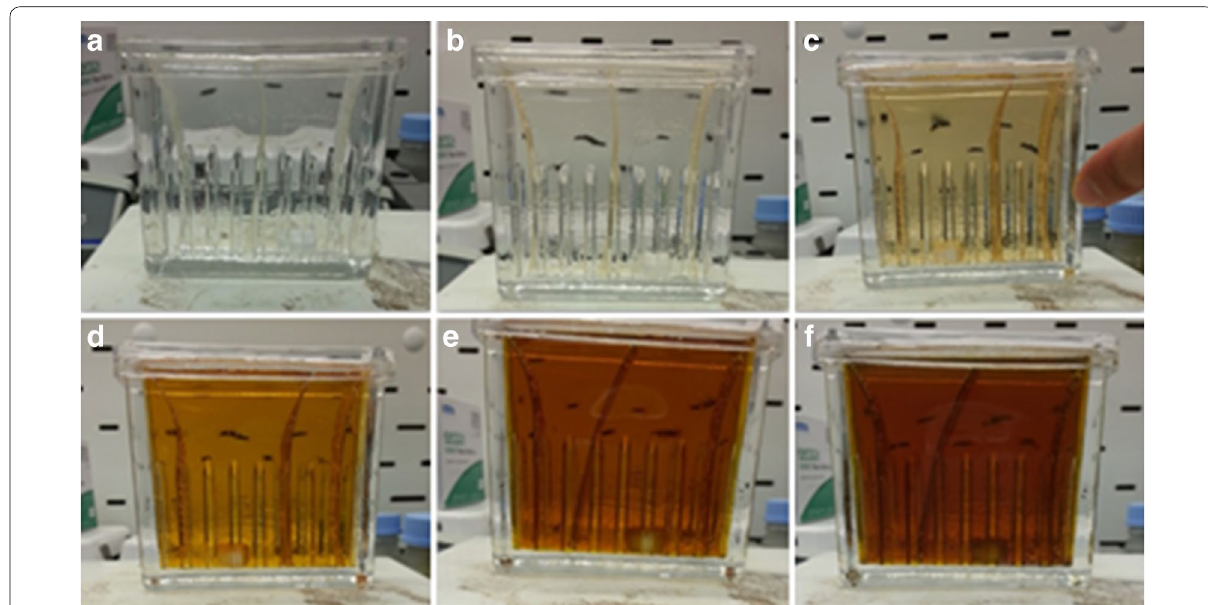
Fig. 4 Time-dependence of the AgNP growing reaction on PDMS film in a solution that contained AgNPs at 80 °C after the addition of sodium